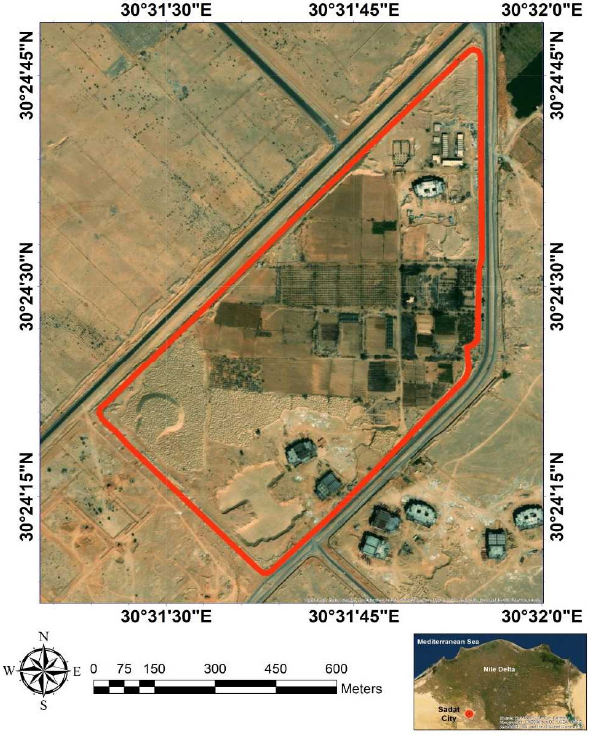
Figure 1. Location of the study field.